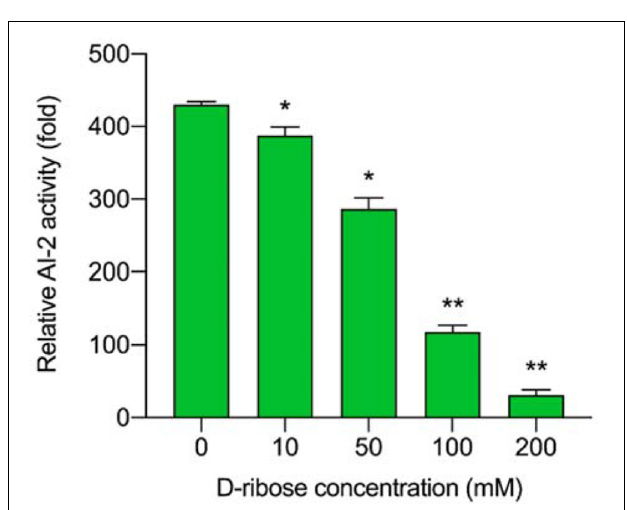
FIGURE 4 | The inhibitory effect of different D-ribose concentrations on AI-2 activity. The relative AI-2 activity is defined as (the RLU of CFS)/(the RLU of blank control). * p < 0.05 and ** p <